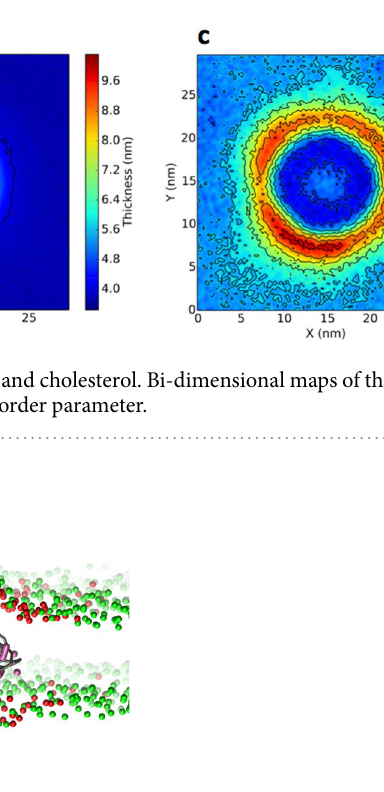
Figure 6. Snapshot from a simulation of the ternary system + PE80 (9.7% in mass), highlighting the presence of cholesterol within the PE aggregate. For phospholipids, only the head groups are shown: DPPC in red, DLiPC in green. The PE chains are in gray, and Chol beads within 0.5 nm of PE are shown in